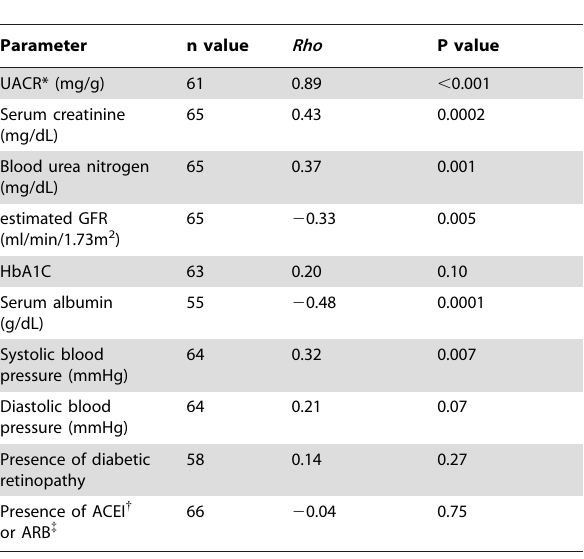
patients with normoalbuminuria, 11 patients with microalbumin- uria, and 29 patients with macroalbuminuria. A significant difference in median urine nephrin-to-creatinine ratio (UNCR) was observed between control subjects and all diabetic categories (p , 0.0001) (Table 2). In addition, nephrinuria was detected in Table 3. Correlations of urine nephrin-creatinine ratio (UNCR) with clinical